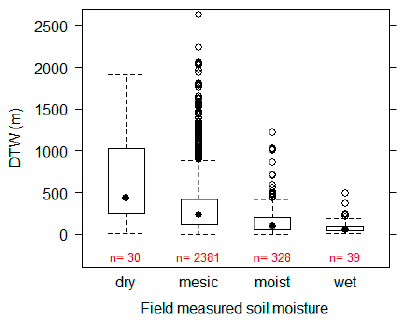
Figure 2. Box and whiskers plot of the digital depth to water value in the field-measured soil moisture classes: dry, mesic, moist and wet. The number of sample plots in each category ( n ) is shown in red below each box. Black dots indicate median, the border of the box indicates the first and third quartile, length of whiskers represents approximately two standard deviations of the data, and the unfilled dots indicate outliers of the whiskers.